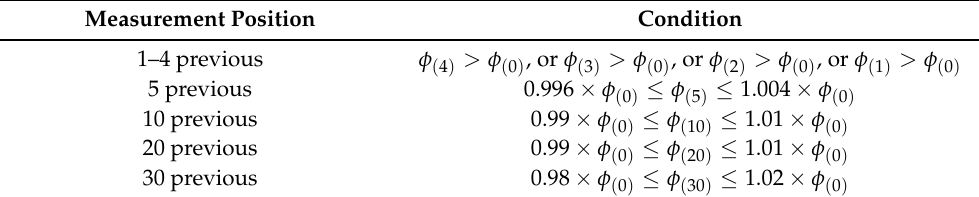
Figure 2. Schematic of the experimental procedure. The heating coil that is bonded to the heat sink by the TIM is placed on top of a thermocouple and teflon insulator. The computer continually reads thermocouple and changes the power supply’s current to the heating coil when certain conditions are met. Table 1. The set of conditions that define equilibrium temperature at a given heat dissipation level, where φ ( x ) is the temperature recording x iterations back from the most recent measurement, φ ( 0 )